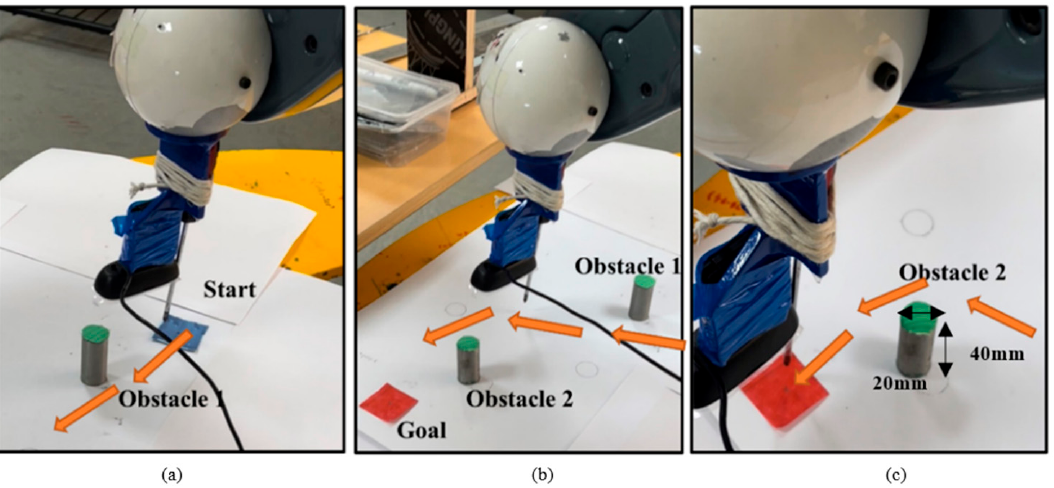
Figure 16. Real-time Path Traversed by the Robot with Two Obstacles using Double DQN ( a ) At Start Position (Blue), ( b ) At Middle Position, and ( c ) Goal Position (Red). The Yellow Colored Arrow Illustrates the Path taken by the Agent.